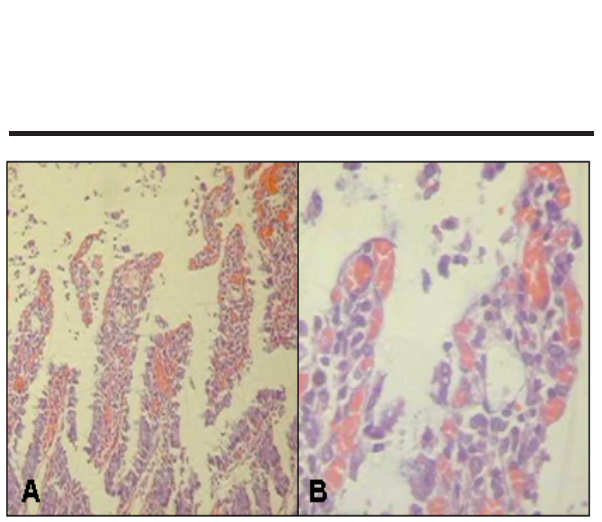
FIGURE 5 - Microphotograph of level 2 of Chiu’s Score’ of intestinal mucosa (HE, A x100, B x400)